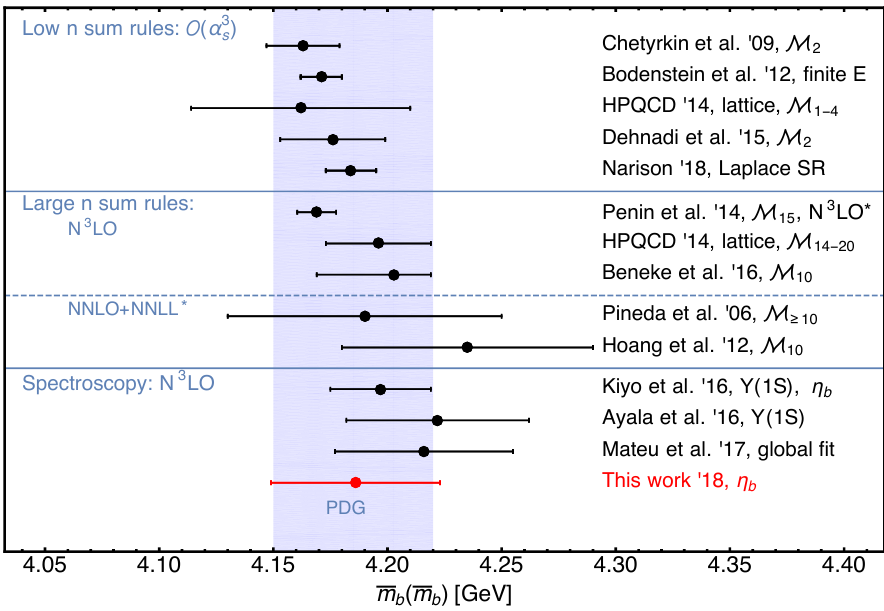
Figure 2 . m b ( m b ) determined from spectroscopy or from sum rules in the strict weak-coupling approximation. Chetyrkin et al. [37], HPQCD14 [38], and Dehnadi et al. [39] use N 3 LO low n moments equated to the corresponding experimental moments evaluated using the available exper- imental information (masses and decays) supplemented with lattice information and/or assuming perturbation theory at high energies. Finite energy [40] or Laplace [41] sum rules have also been applied for low n . Penin et al. [42] and Beneke et al. [43, 44] uses nonrelativistic (with Coulomb resummation) N 3 LO large n moments (the (cid:12)rst reference uses a partial result). Pineda et al. [45] and Hoang et al. [46] use NNLO and (a partial) NNLL expression for nonrelativistic (with Coulomb resummation) large n moments. Kiyo et al. [26], Ayala et al. [27], Mateu et al. [28] and this paper use N 3 LO expressions for the heavy quarkonium